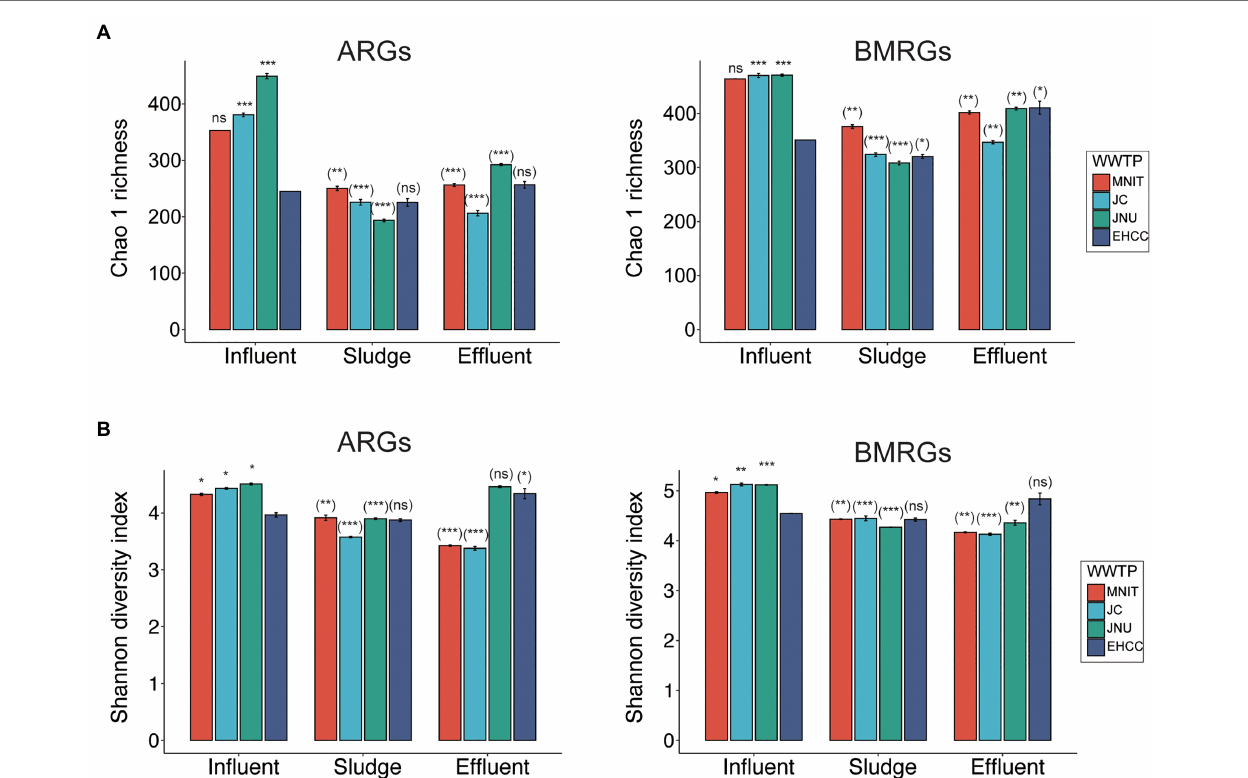
FIGURE 1 | Alpha diversity of ARGs and BMRGs. Bar diagrams show the chao1 richness (A) and Shannon diversity (B) of ARGs and BMRGs based on ARGs/ BMRGs subtypes in influents, sludges, and effluents of four WWTPs. Data are mean ± standard deviation. The Chao1 richness of ARGs/BMRGs for influents of MNIT or EHCC were identical in two replicas, therefore the standard deviations for them were zero. Significances between the influents of MNIT/JC/JNU vs. influent of EHCC (outside brackets) and between influent and sludge/effluent for each WWTP (inside brackets) were indicated by using Welch’s t -test. * p < 0.05; ** p < 0.01; *** p < 0.001; ns, not